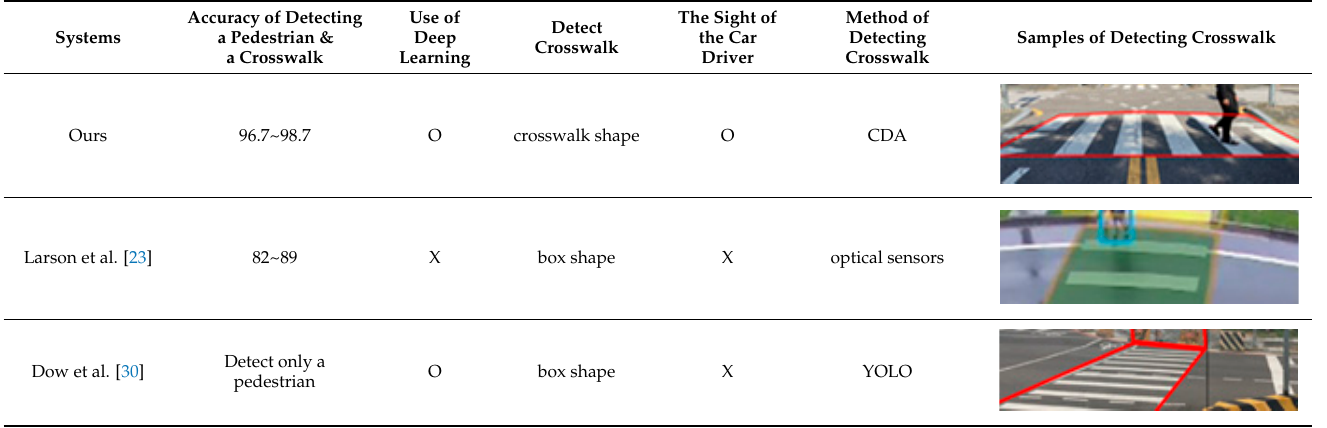
Table 1. Comparison of our system to others; Accuracy and CDA.